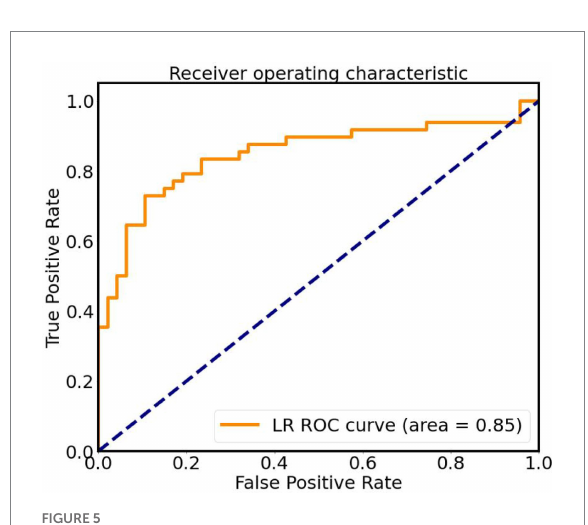
FIGURE 5 ROC curve of classifier based on altered Reho and FC values, AUC is 0.85. LR, logistic regression; ROC, receiver operating